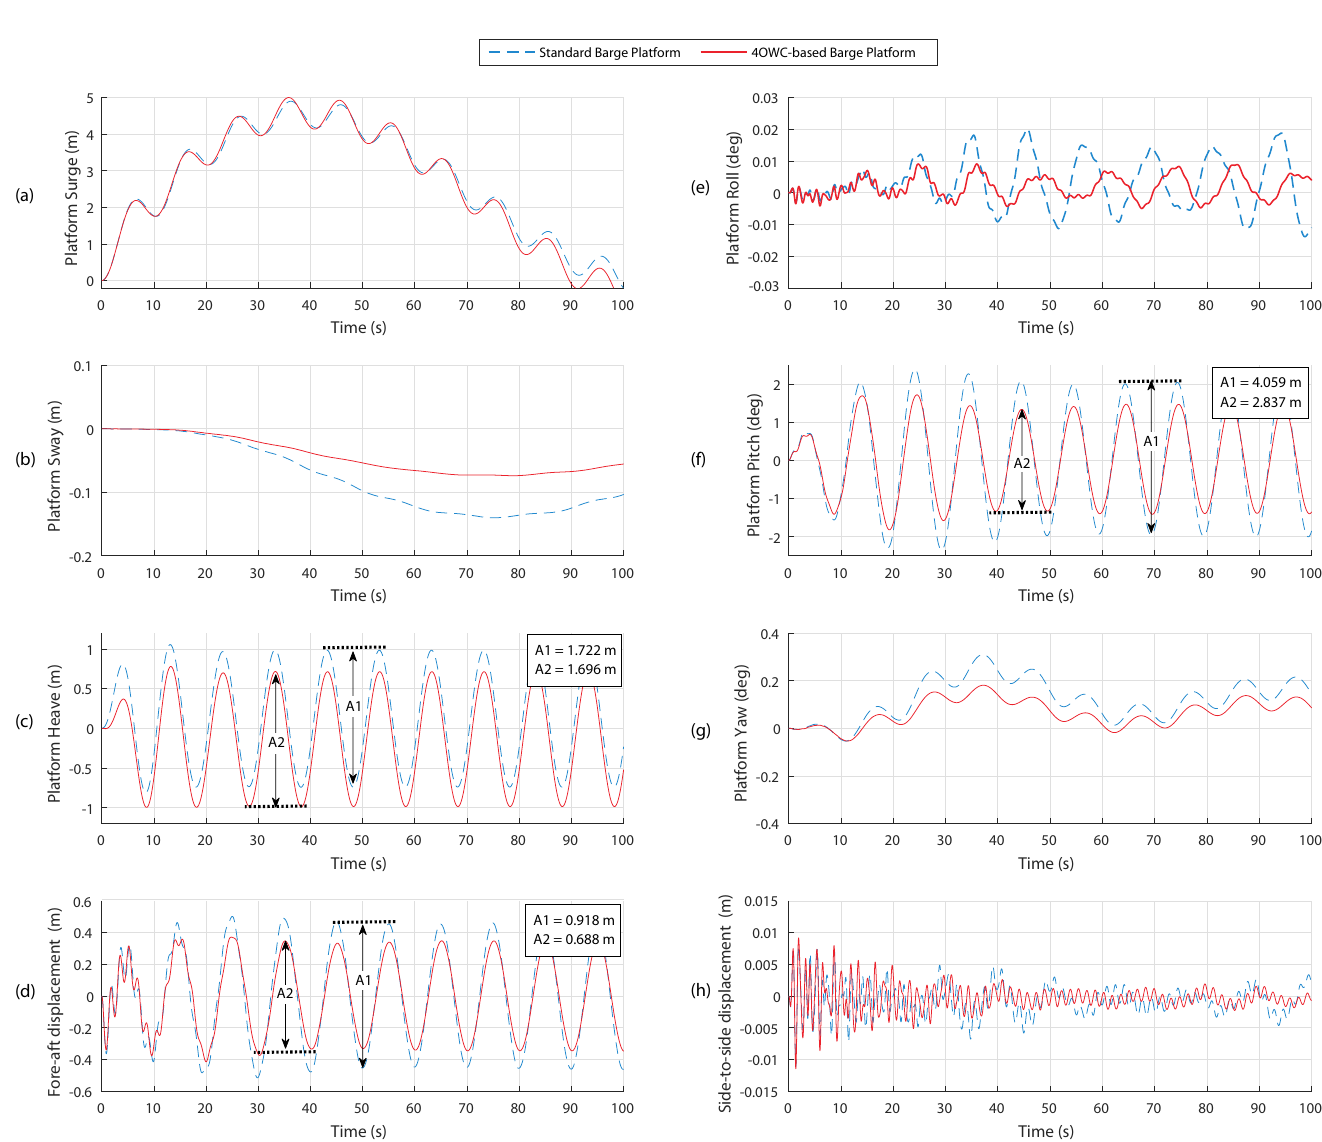
Figure 10. Platforms’ modes for ( a ) Surge. ( b ) Sway. ( c ) Heave. ( d ) Fore-aft. ( e ) Roll. ( f ) Pitch. ( g ) Yaw. ( h ) Side-to-side. The SRAO at the period of 10 s for the standard barge is lower than that of the proposed platform, illustrated in Figure 5a. It agrees with the platform surge